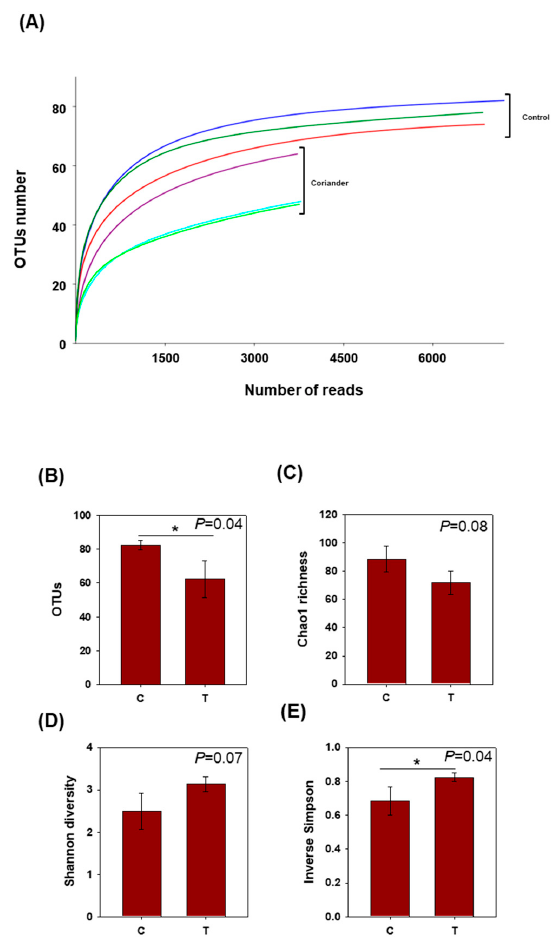
Figure 1. ( A ) Rarefaction curves of the obtained 16S rRNA sequence reads against the assigned operational taxonomic units (OTUs). Alpha diversity in soy sauce samples prepared by adding coriander, compared to that in control. ( B ) Number of OTUs, ( C ) Chao1 richness index, ( D ) Shannon diversity index, and ( E ) inverse Simpson’s index. Data represent means and standard deviations of three replicates for each soy sauce group. *: a significant di ff erence at p < 0.05. C = control, T = coriander